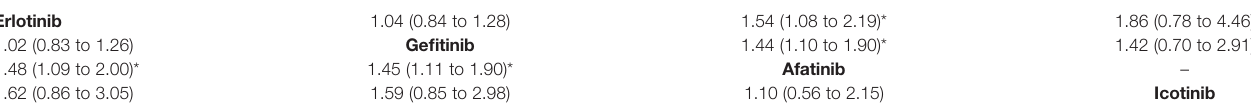
Pairwise (upper-right portion) and network (lower-left portion) meta-analysis results are presented as estimated effect sizes as mean difference (MD) and 95% con fi dence interval for the outcome of the acquired T790M mutation rate. An MD > 0 favors treatment in the column for the acquired T790M mutation rate. *Statistically signi fi